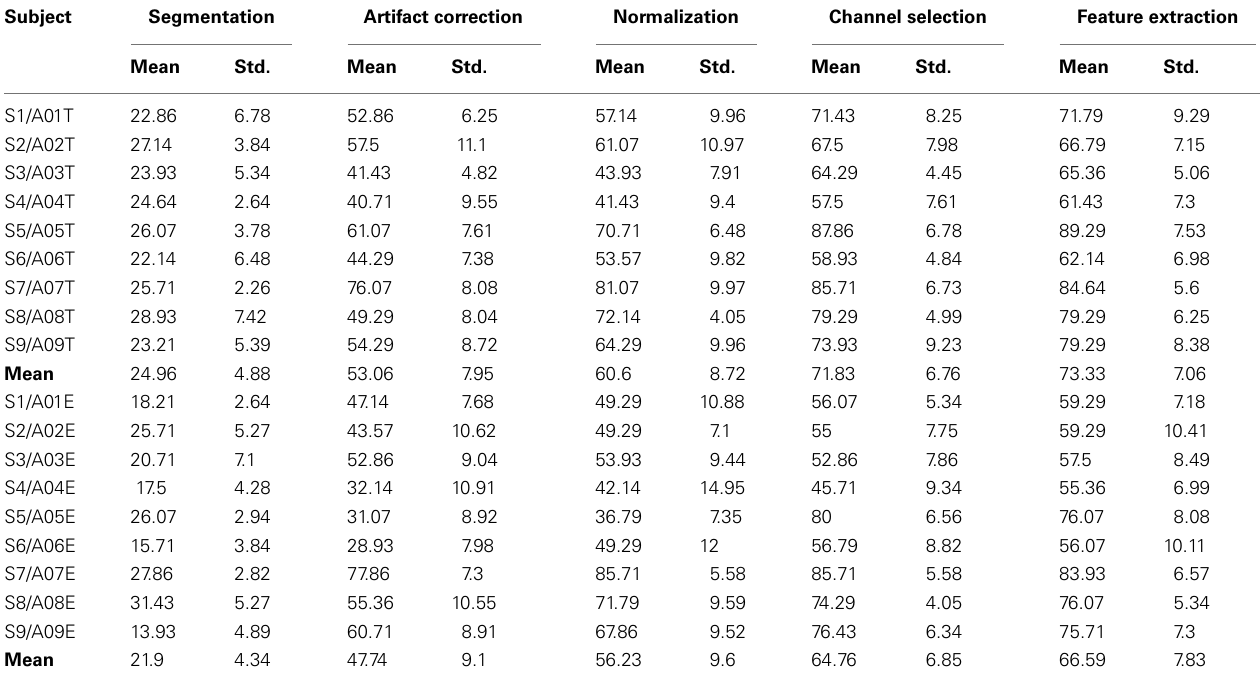
Table 3 | Comparison of 10-fold cross-validation classification accuracy (%) for each processing stage presented in this paper for each subject on the training set (session 1) and test set (session 2).